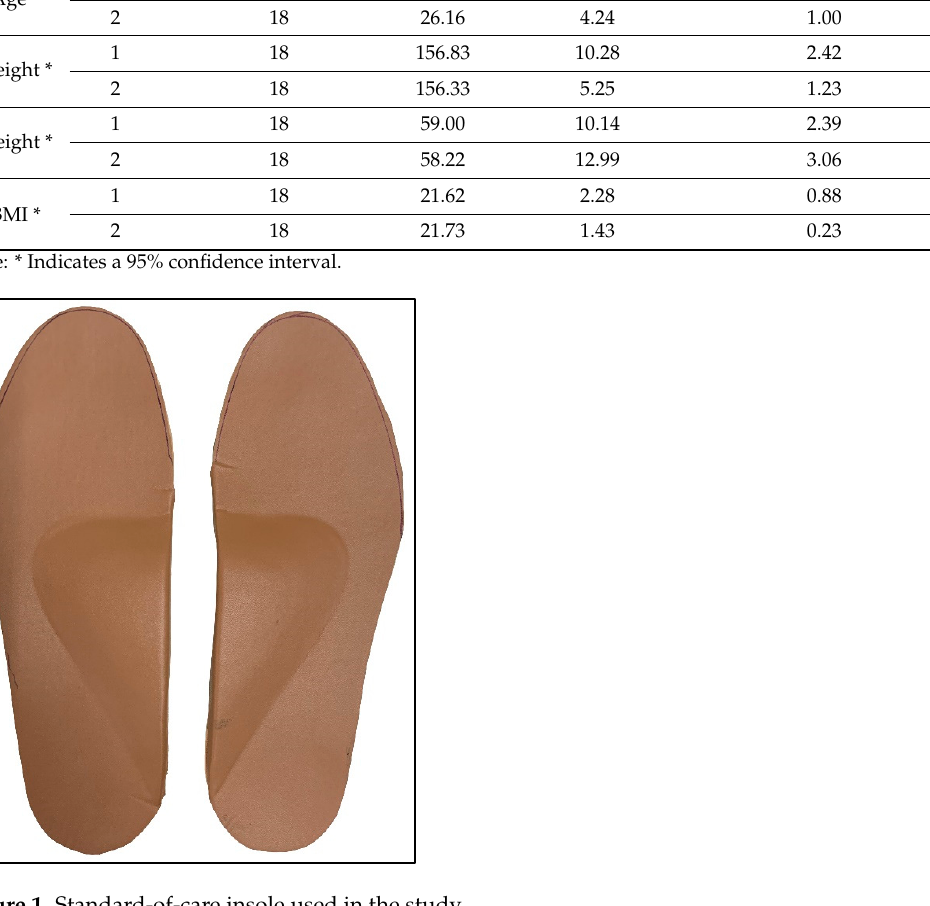
Figure 1. Standard-of-care insole used in the